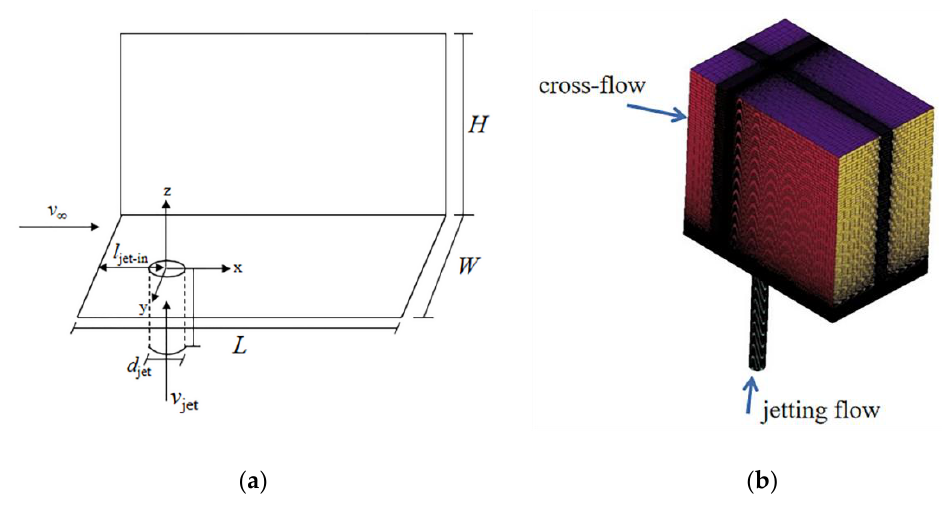
Figure 2. ( a ) Schematic diagram of cross-flow and ( b ) 3D model of cross-flow with 2.61 million grid cells. Table 2. Dimensional details of cross-flow in the mesh sensitivity analysis.